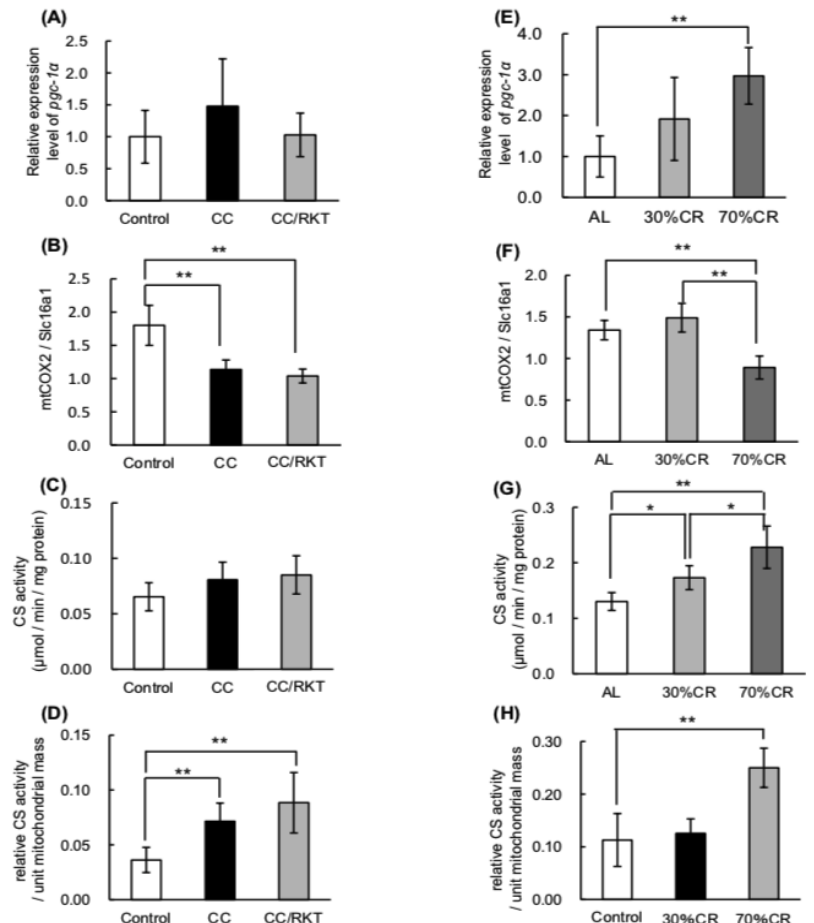
Figure 5. Effects of cancer cachexia (CC), rikkunshito (RKT), and caloric restriction (CR) on the expression of Pgc-1 α mRNA, mitochondrial DNA (mtDNA) content, and citrate synthase (CS) activity in epididymal white adipose tissue (eWAT). To measure Pgc-1 α mRNA levels by real-time RT-PCR, total RNA was extracted from eWAT of ( A ) control, CC, and CC/RKT rats, and ( E ) rats fed ad libitum (AL) and subjected to CR. Pgc-1 α mRNA levels were normalized to Tbp mRNA levels. The ratio of mitochondrial (COX2) to nuclear (SLC16A1) DNA was obtained using real-time PCR and DNA extracted from eWAT of ( B ) control, CC, and CC/RKT rats, and ( F ) AL and CR rats. Ratios are expressed as fold changes relative to mean values for control or AL rats. Citrate synthase (CS) activity in eWAT of ( C ) control, CC, and CC/RKT rats, and ( G ) AL and CR rats, was measured spectrophotometrically at 412 nm. CS activity to mtDNA content ratio, indicative of mitochondrial enzymatic activity per unit mitochondrial mass, was calculated for the eWAT of ( D ) control, CC, and CC/RKT rats, and ( H ) AL and CR rats. Error bars represent the SD associated with each mean ( n = 5–6). * p < 0.05, ** p < 0.01 by Tukey’s test.